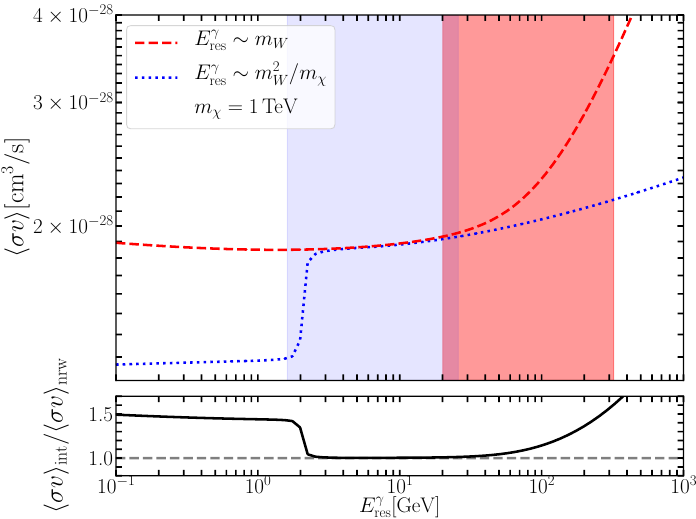
Figure 3 . Annihilation cross sections plotted as function of E (cid:13) narrow resolution. The red-dashed line shows the intermediate resolution cross section. The light- grey (blue) area represents the region of validity of the narrow resolution case and the dark-grey (red) area represents the region of validity of the intermediate resolution case as described in the text. The ratio of the intermediate to narrow resolution annihilation cross section is added below. The results are shown for a DM mass of m (cid:31) = 1